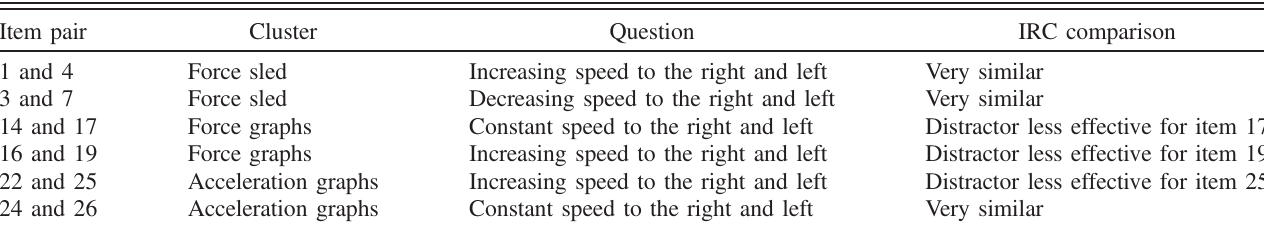
TABLE III. Description of items of symmetrical